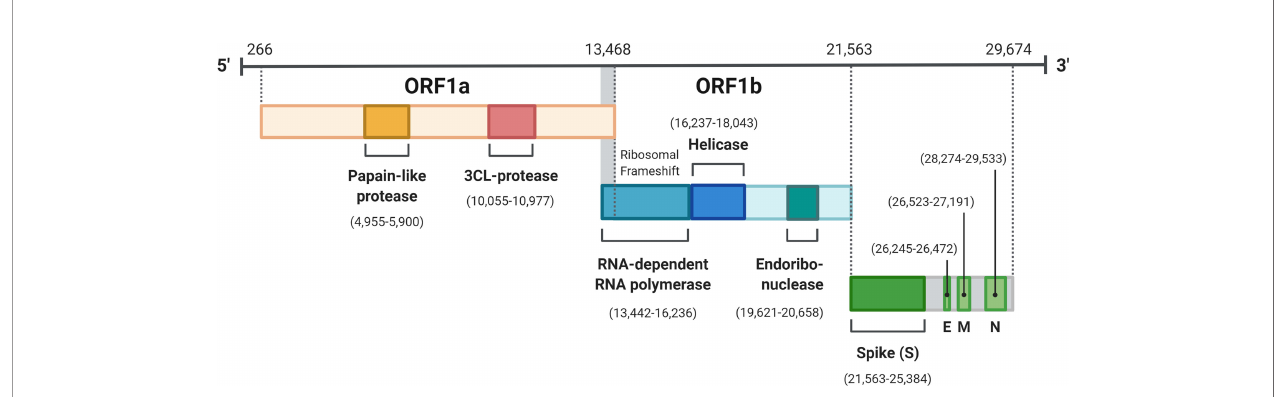
FIGURE 1 | SARS-CoV-2 genome organization. ORF 1a and 1b translated to pp1a and pp1ab are the two polypepdies which are processed into the 16 nonstructual proteins. The four structural proteins are S, spike; E, envelope; M, membrane; N, nucleocapsid. Created with